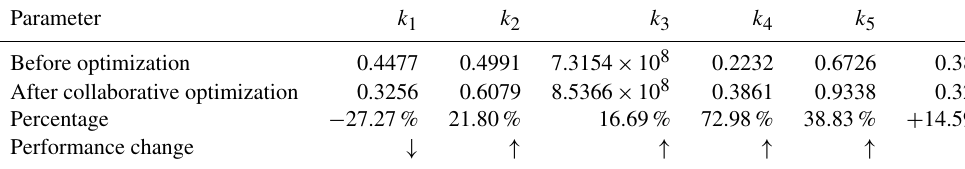
Table 6. Comparison of objective function values after an improved collaborative multi-objective optimization algorithm. Parameter k 1 k 2 k 3 k 4 k 5 k 6 Before optimization 0.4477 0.4991 After collaborative optimization 0.3256 Performance change